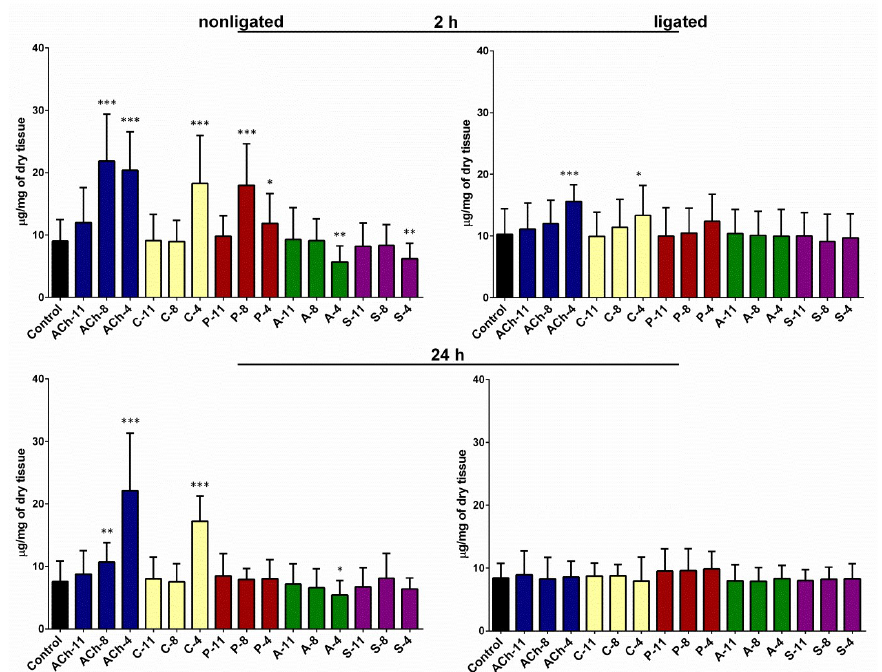
Figure 2. Glycogen content in the midgut of nonligated and neck-ligated larvae of T. molitor beetles injected with acetylcholine (ACh), carbachol (C), pilocarpine (P), atropine (A), and scopolamine (S) at concentrations of 10 − 11 (X-11), 10 − 8 (X-8) and 10 − 4 M (X-4) for each compound. The samples were isolated 2 or 24 h after injection. The control larvae were treated with saline. Mean ± SD are given for 15–25 individuals. Statistically significant differences from the control values are indicated by asterisks (Student’s t -test), where * p ≤ 0.05, ** p ≤ 0.01, and *** p ≤ 0.001.